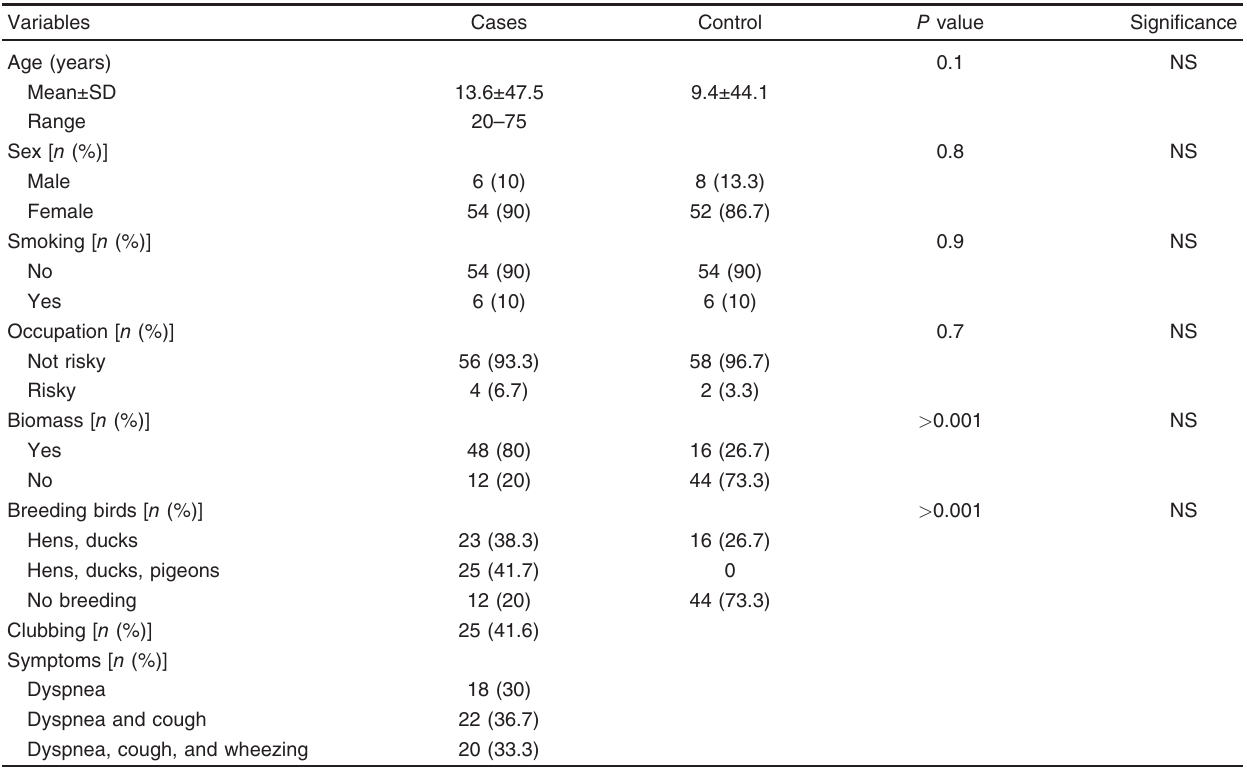
Table 1 Illustration of the demographic data of the studied group